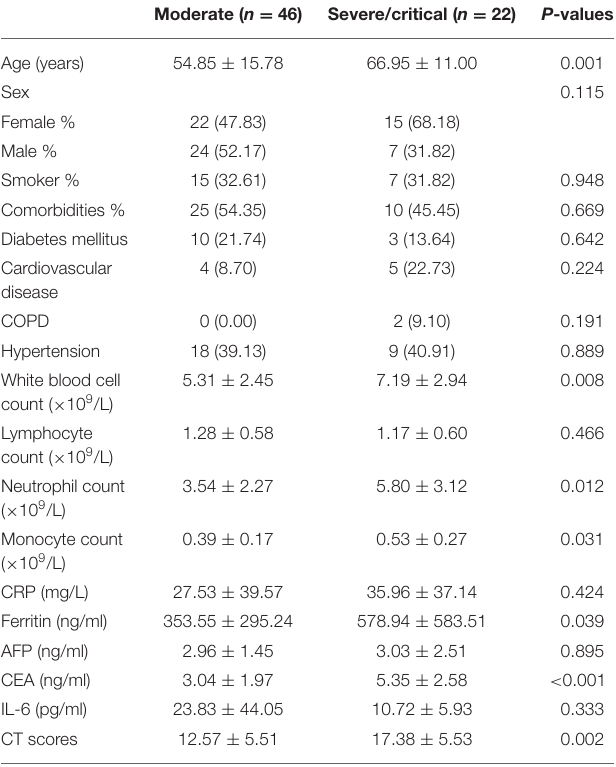
TABLE 3 | Characteristics of 68 discharged patients with different disease severities.